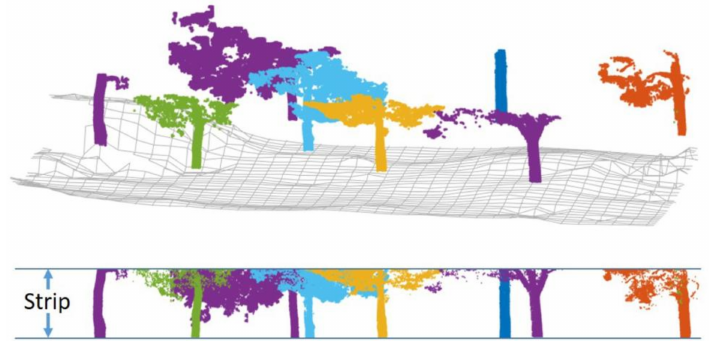
Figure 10. Strip limiting the search of trunks and group of voxels that represent each trunk.